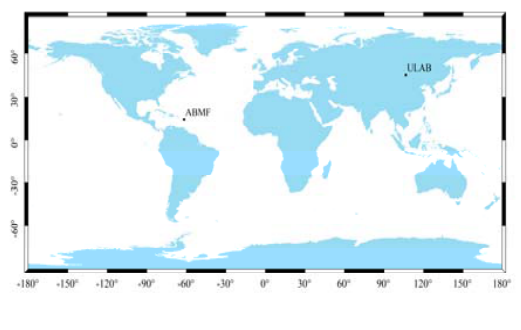
Figure 2. ABMF and ULAB IGS-MGEX